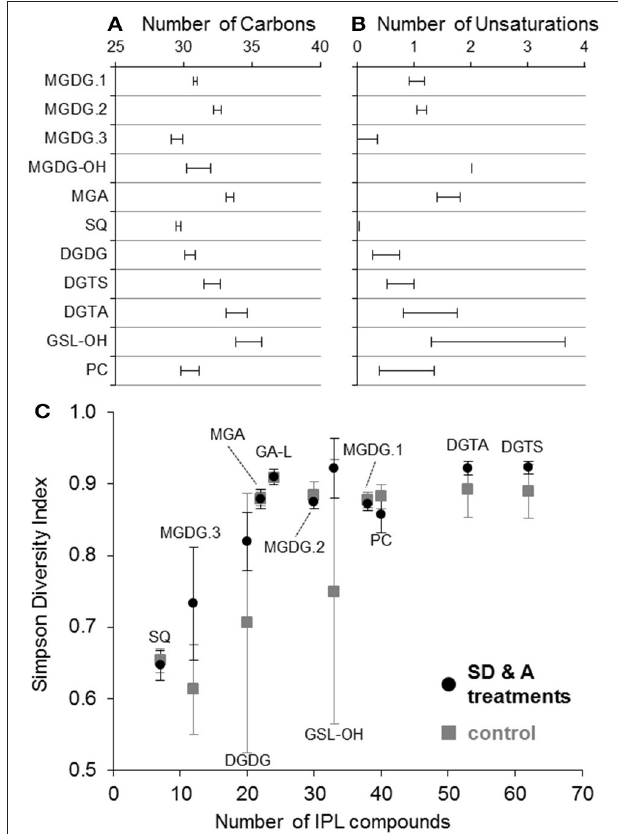
FIGURE 4 | Weighted average ( ± 1 standard deviation) number of carbons (A) and unsaturations (B) in the alkyl chain of IPLs. The Simpson diversity index of each IPL class (C) was determined as: N (fractional abundance) 2 , where f is the fractional abundance of lipid i , 1 − P i = 1 and N is the total number of lipids in each IPL class. The average Simpson index values for IPL classes in control ( n = 8; gray squares) and treatment samples collected on days 3 and 6 ( n = 10; black circles) are plotted against the total number of compounds identified for each IPL class. Error bars indicate one standard